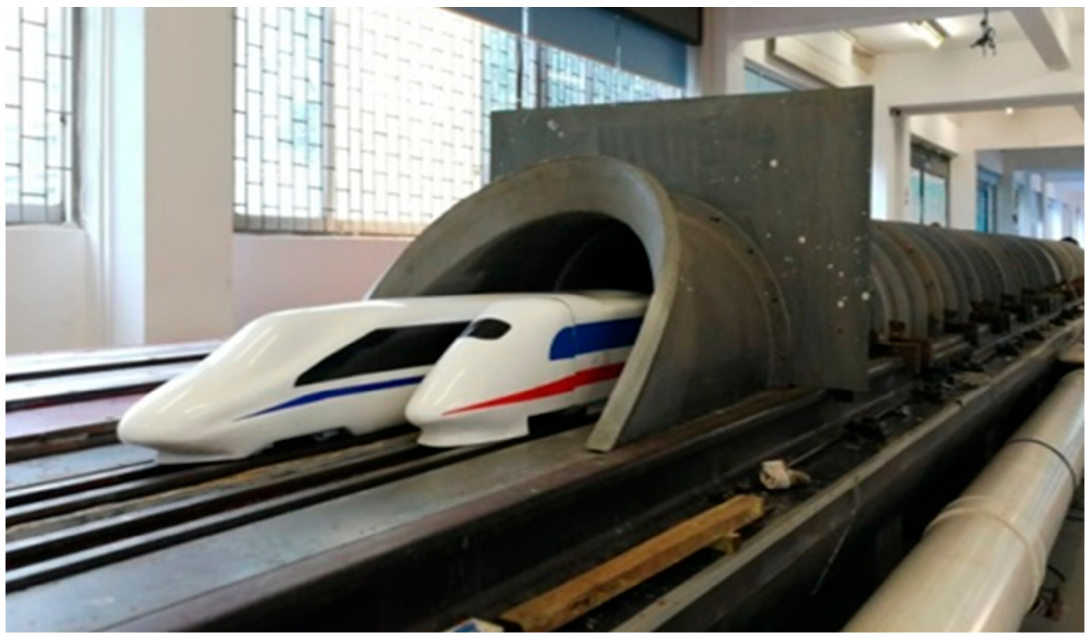
Figure 3. Train isometric model.